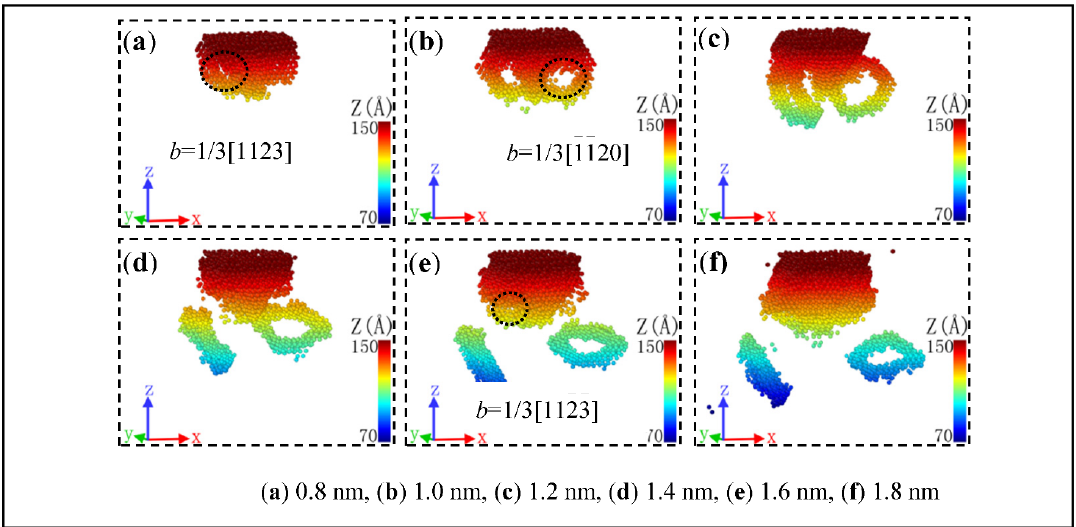
— 00) crystal surface with different indentation depths. Figure 3. Deformation process of 6H-SiC (1100) crystal surface with different indentation